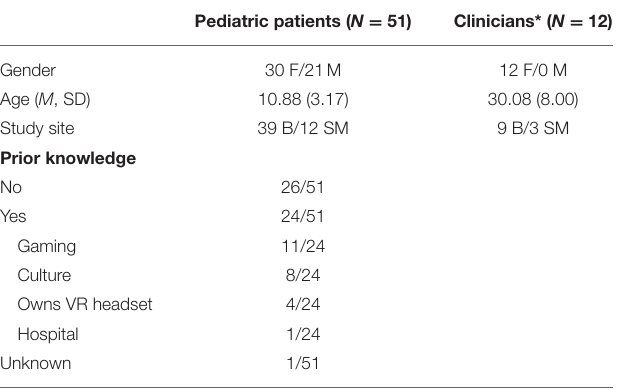
TABLE 1 | Demographic information and baseline descriptives.